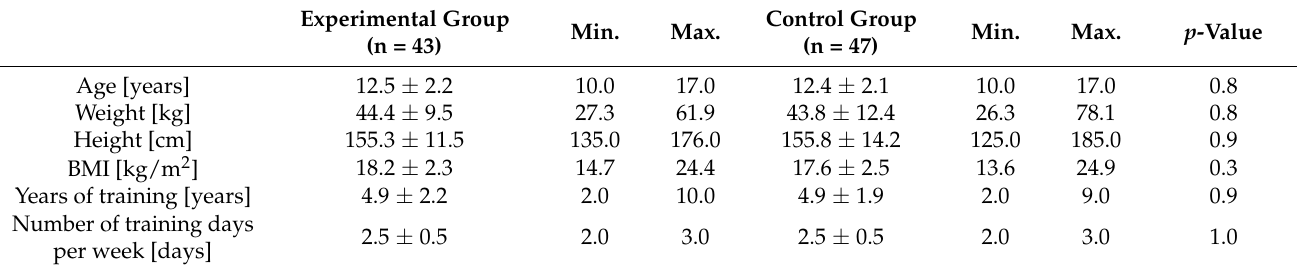
Table 1. Intergroup comparison of players in terms of basic